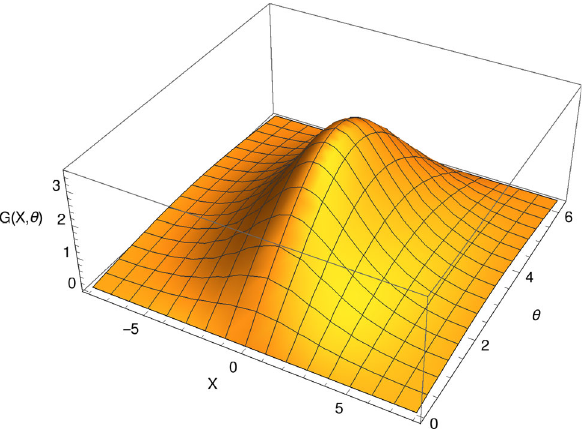
Fig. 2 The metric function G as a function of X and θ